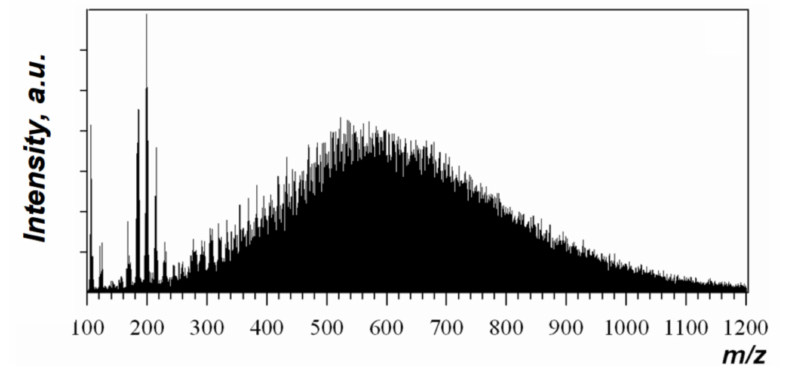
Figure 5. Mass spectrum of asphaltenes acquired by APPI-MS adapted from [78].